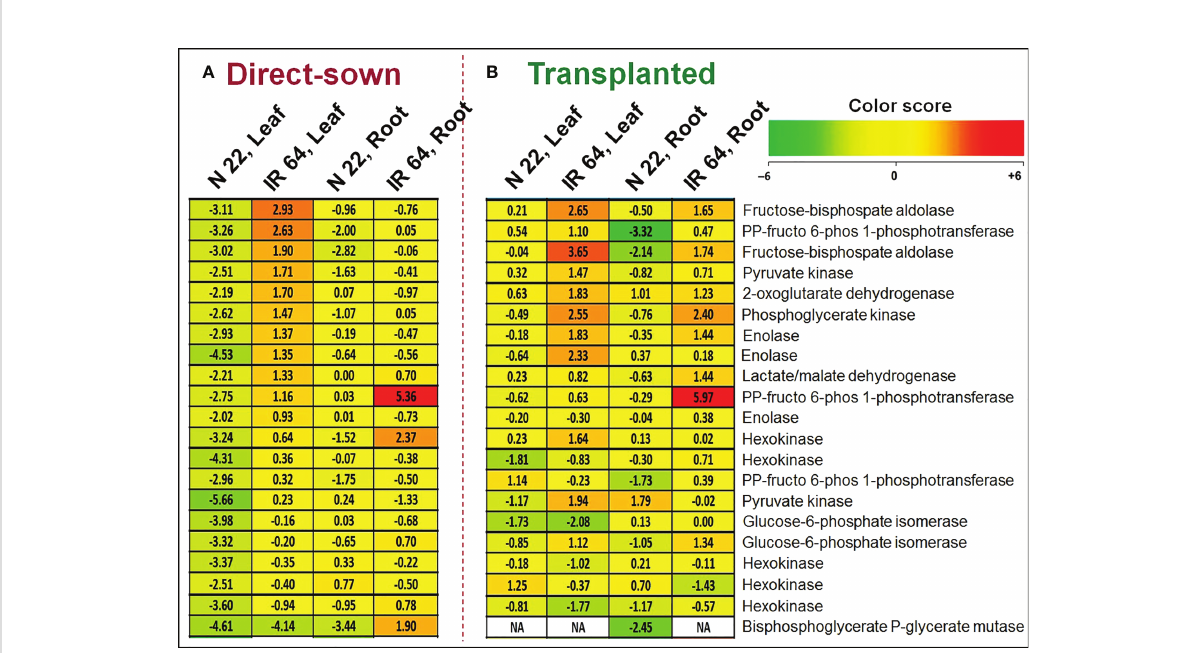
FIGURE 8 Differential expression of genes for carbohydrate metabolic processes. (A) Differentially expressed genes (DEGs) in leaf and root of Nagina 22 and IR 64 under direct-sown conditions subjected to drought stress at the reproductive stage of plant growth, (B) DEGs in leaf and root of the rice cultivars under transplanted conditions subjected to drought stress. The expression level of the genes is represented at log2 Fold Change under drought stress over the